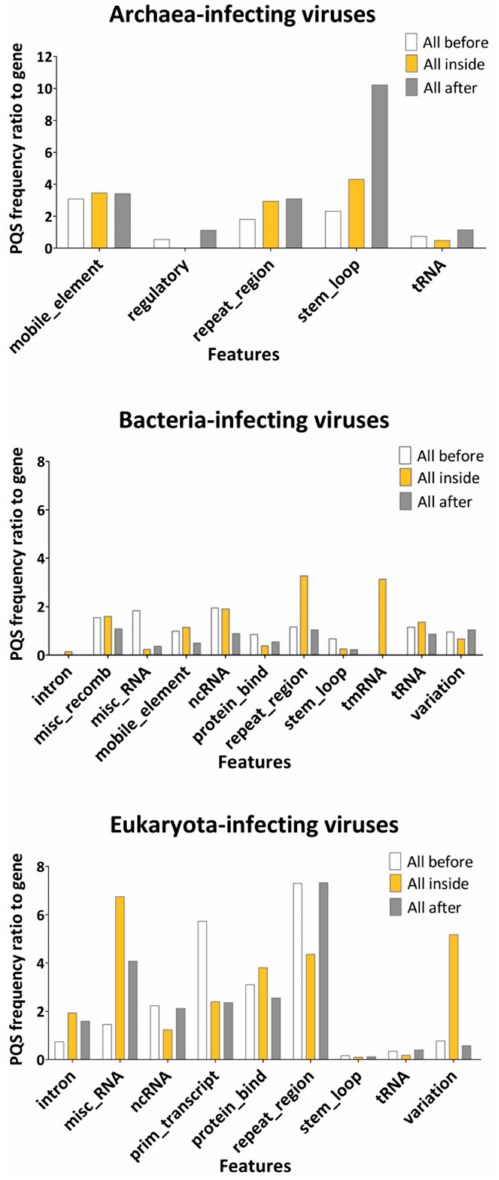
Figure 4. The ratio of PQS frequencies per 1000nt between gene annotation and other annotated locations from the NCBI database. PQS frequencies within (inside), before (100 nt), and after (100 nt) annotated locations were analyzed. Detailed results are summarized in Supplementary Materials